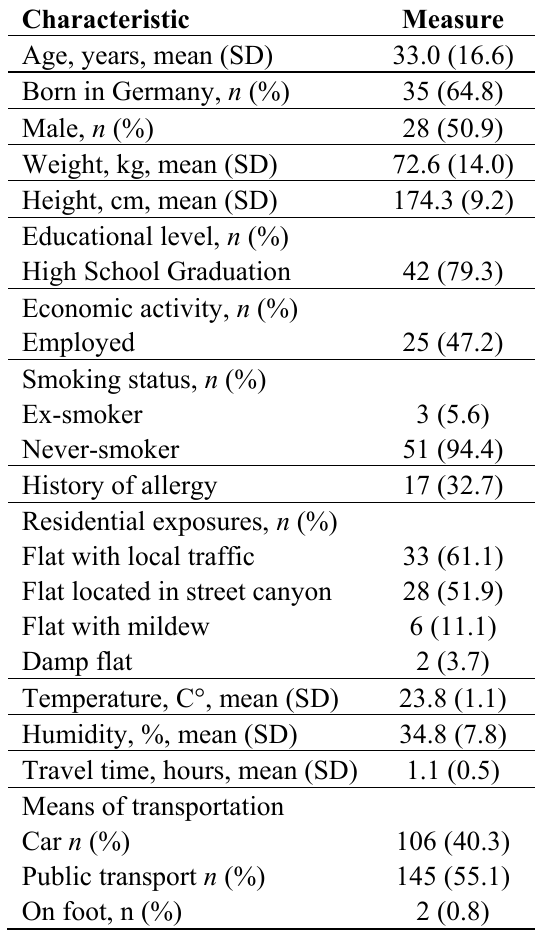
Table 1. Personal and exposure session characteristics of 55